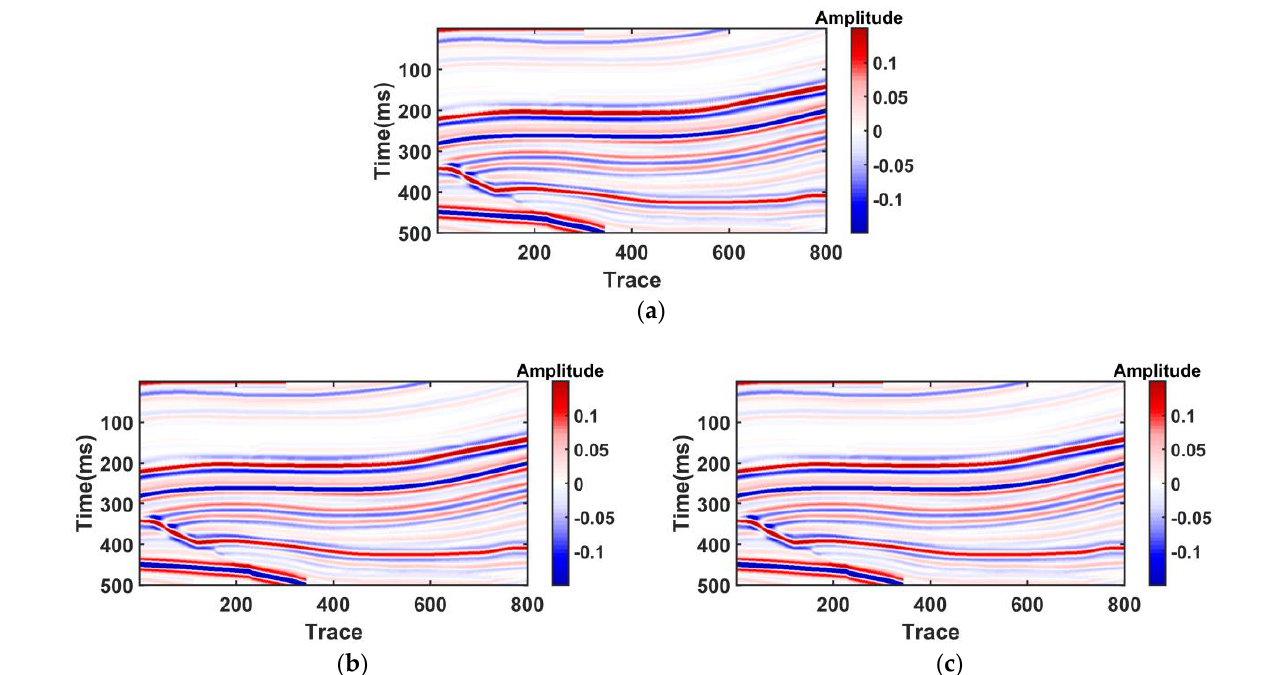
Figure 2. Stacked data volume with different incident angles: (a) 10°; (b) 20°; (c) 30°.